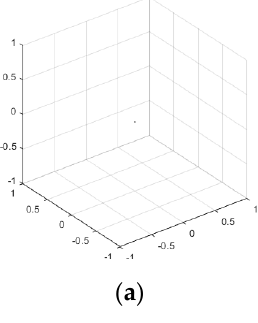
Figure 7. Experimental Data at 5H57M: ( a ) 3D Point Cloud; ( b ) Image of Camera; ( c ) Image of IP Camera.